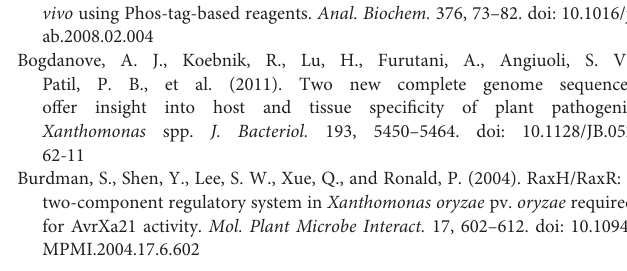
Supplementary Figure 1 | Schematic representation for the construction of non-polar deletion mutant strain R ρ vemR in X. oryzae pv. oryzicola via double homologous crossover events. The primer pairs used for the verification of the deletion event are appropriately indicated. Supplementary Figure 2 | Putative VemR interactions in X. oryzae pv. oryzicola identified via Simple Modular Architecture Research Tool (SMART)